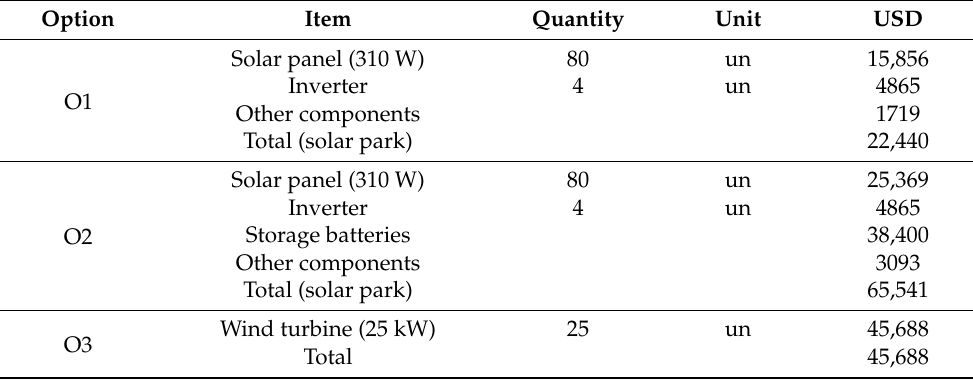
Table 8. Capital expenditure (equipment) for O1, O2, and O3.